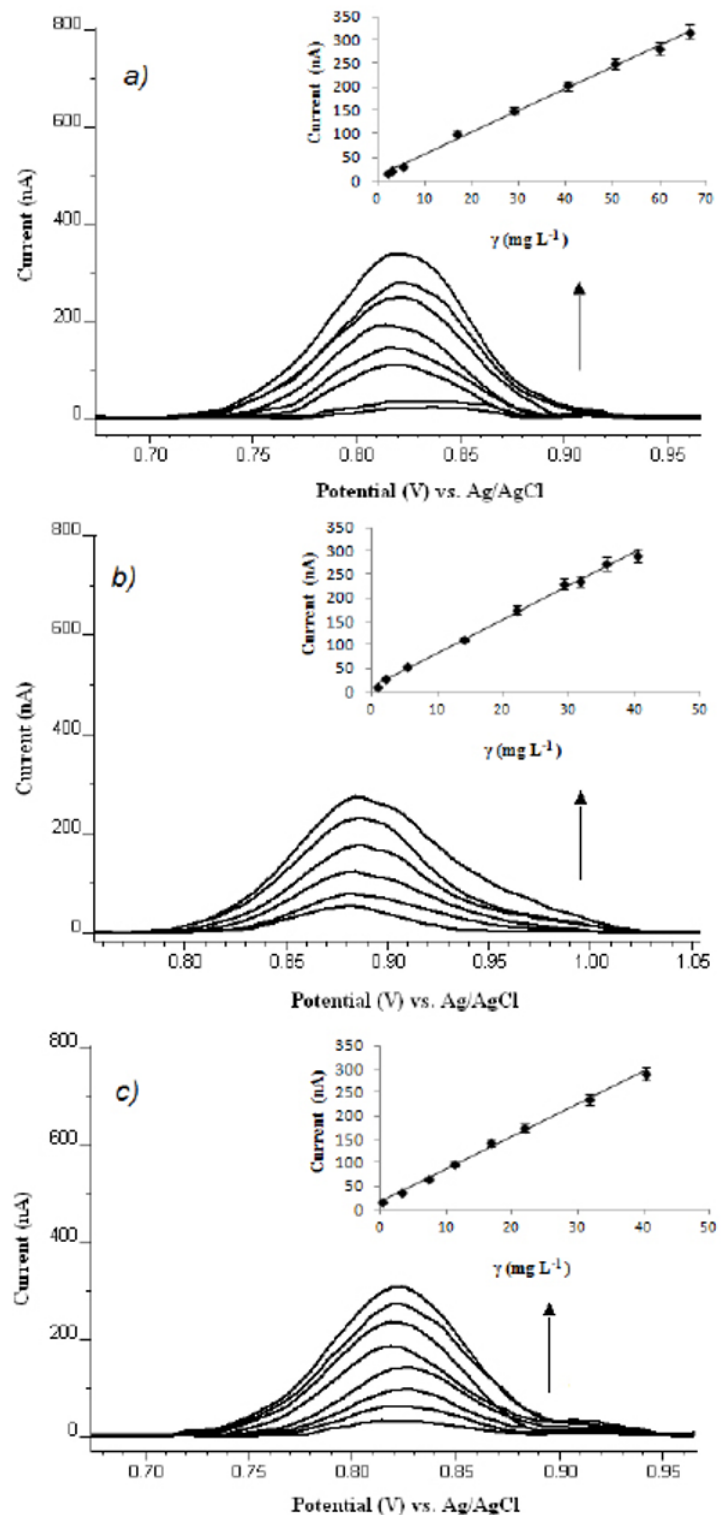
Figure 7. DPV signal of guanine at different preatreated electrodes: a) MWNTPE concentrations of dsDNA. The insert figures shows the calibration curves of the dsDNA. Other conditions as described in the section